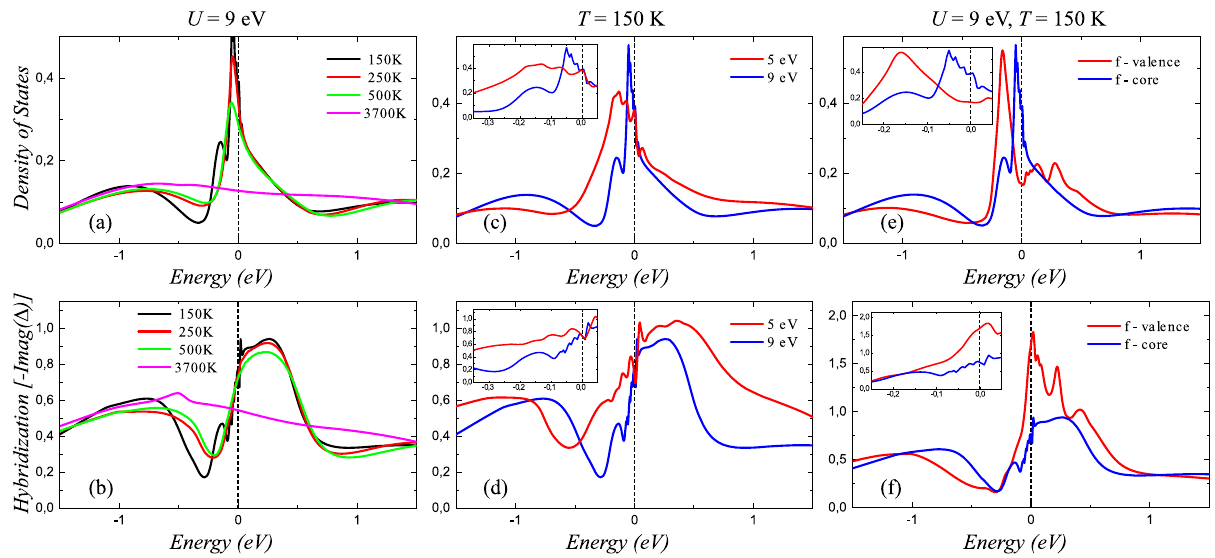
Fig. 4 Density of states (DOS) and hybridization for NdNiO 2 . a , b show the temperature ( T ) dependence of the Ni- d x 2 (cid:3) y 2 projected DOS and the corresponding hybridization, while c , d show the correlation ( U ) dependence of the Ni- d x 2 (cid:3) y 2 projected DOS and the corresponding hybridization. e , f show the “ effects of doping ” on the d x 2 (cid:3) y 2 DOS and its corresponding hybridization, by placing the Nd- f electrons into valence or into the core. The insets focus on the energy region around the Fermi level, which is marked by the zero on the energy